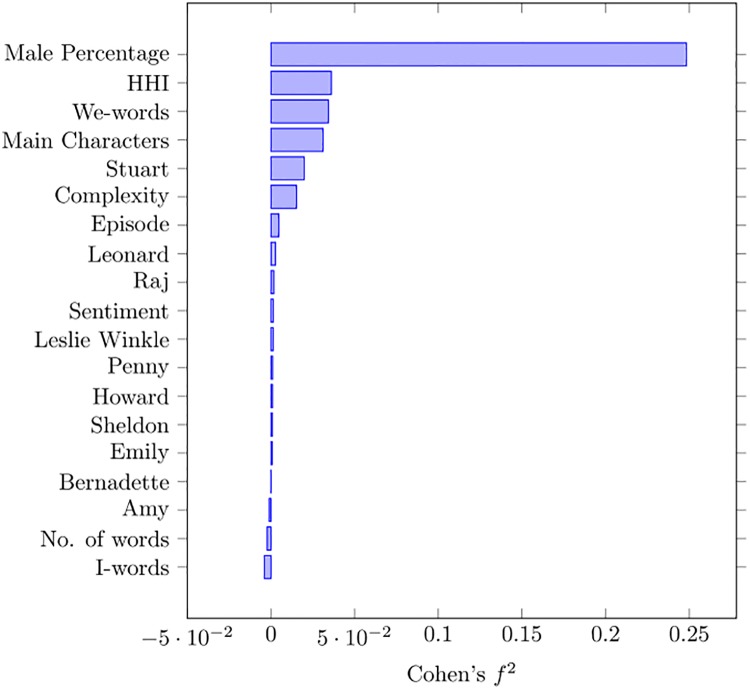
Cohen’s f2 for ratings.